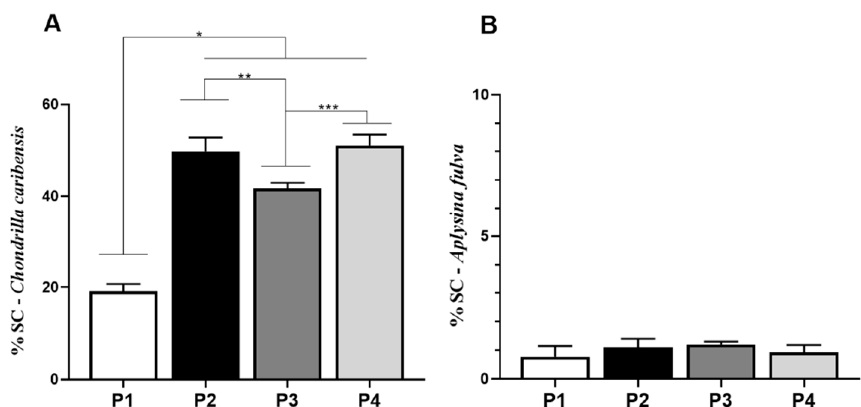
Figure 6. Percentage of SC obtained in extracts analysis by Cloramine T reaction method. ( A ) For